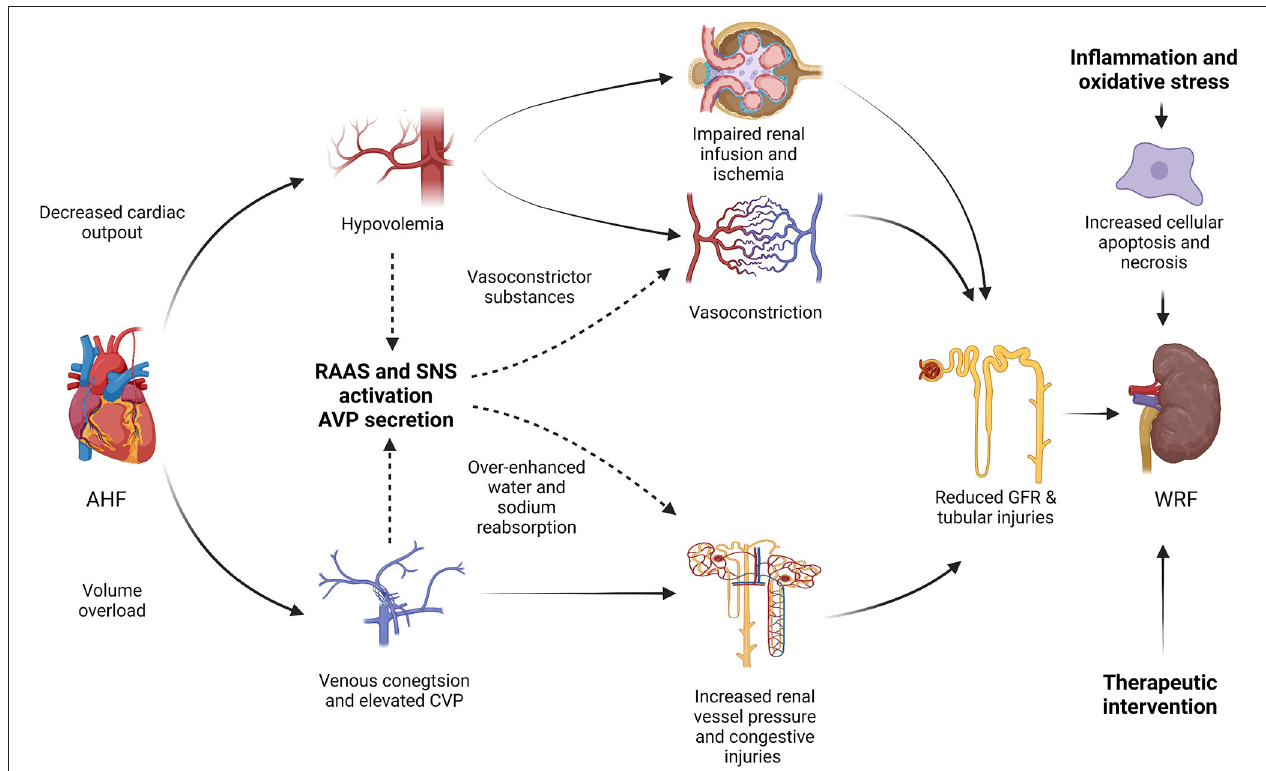
FIGURE 1 | Pathogenesis mechanisms of worsening renal function (WRF) in type-1 cardiorenal syndrome (CRS-1). AHF, acute heart failure; RAAS, renin-angiotensin-aldosterone system; SNA, sympathetic nervous system; AVP, arginine vasopressin; CVP, central venous pressure; GFR, glomerular filtration rate; WRF, worsening renal function; CRS, cardiorenal